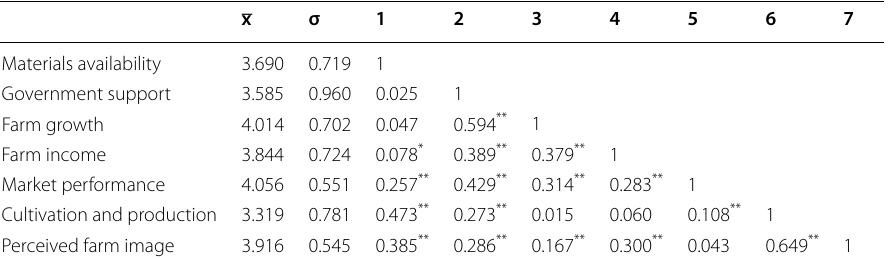
Table 6 Descriptives and correlation